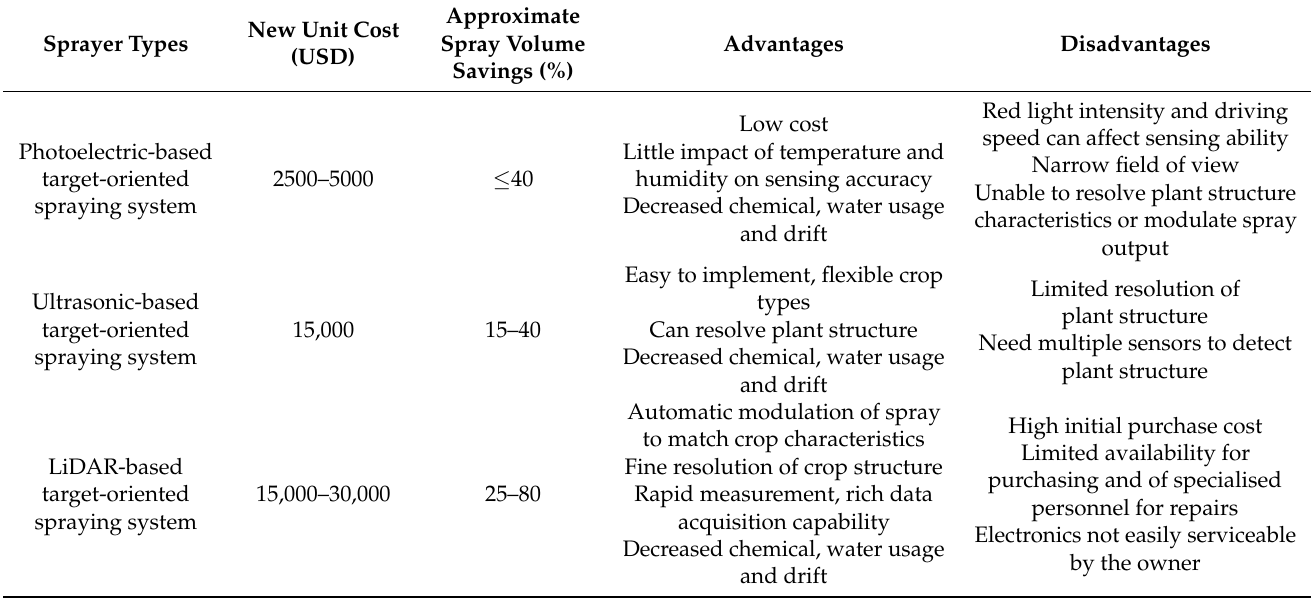
Table 4. Advantages and disadvantages and approximate costs of precision